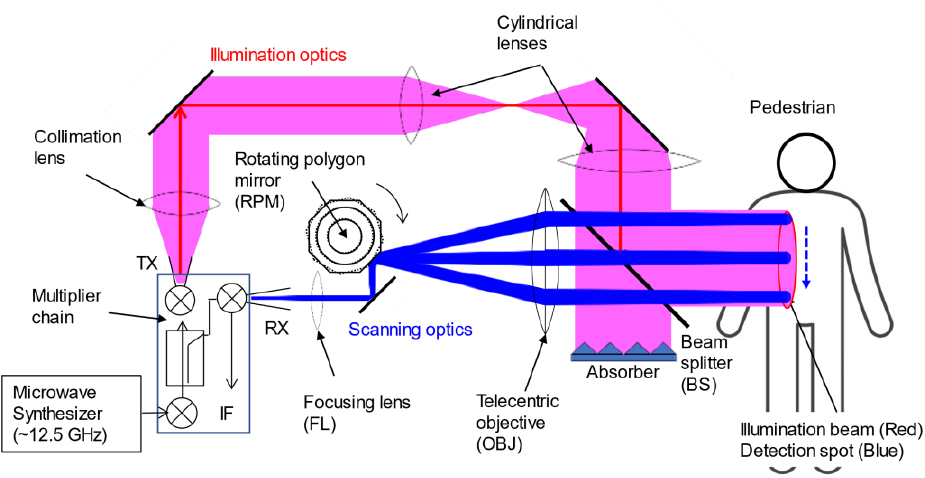
Figure 5. Schematic of the optical system.